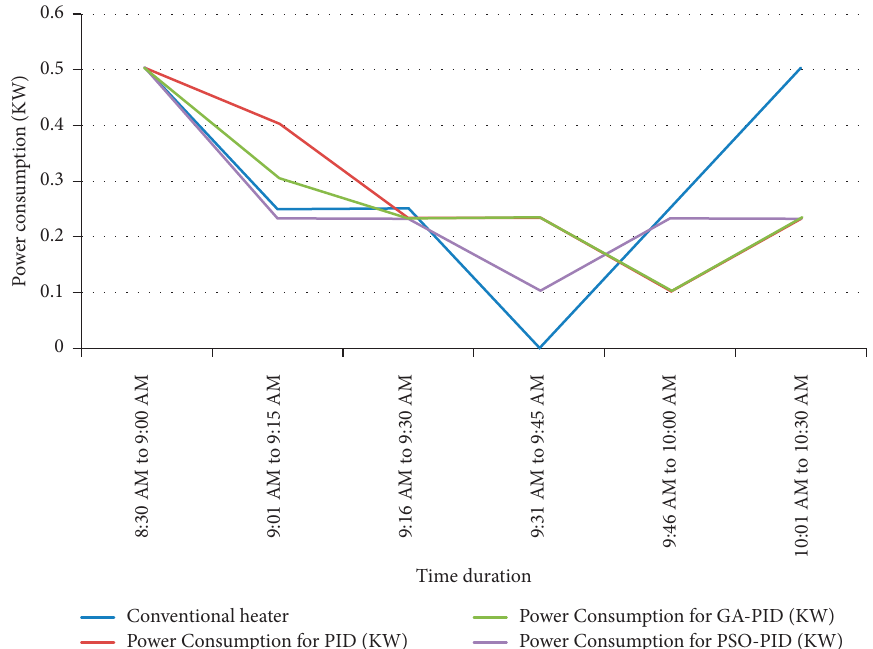
Figure 16: Power consumption for the heater in (KW) for PID, GA-PID, and PSO-PID during the